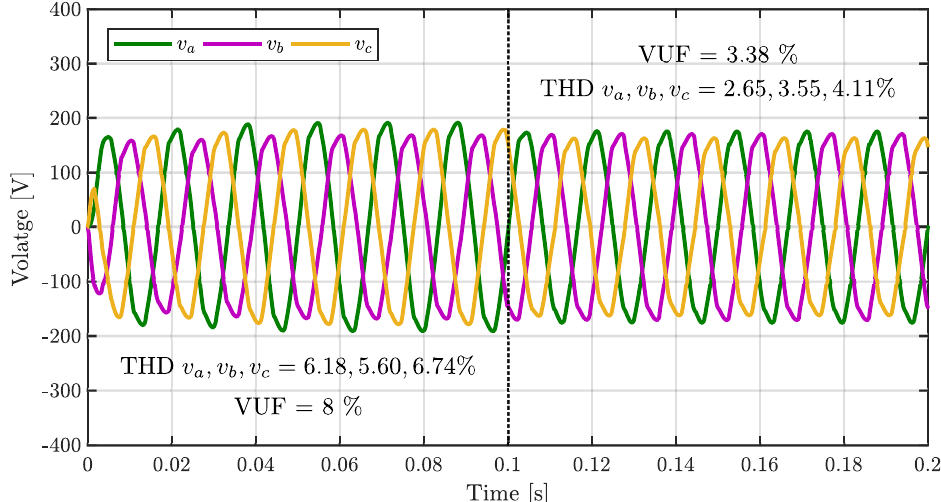
Figure 19. MG response under nonlinear compensation operating in grid-tied mode, and with unbalanced voltage and nonlinear